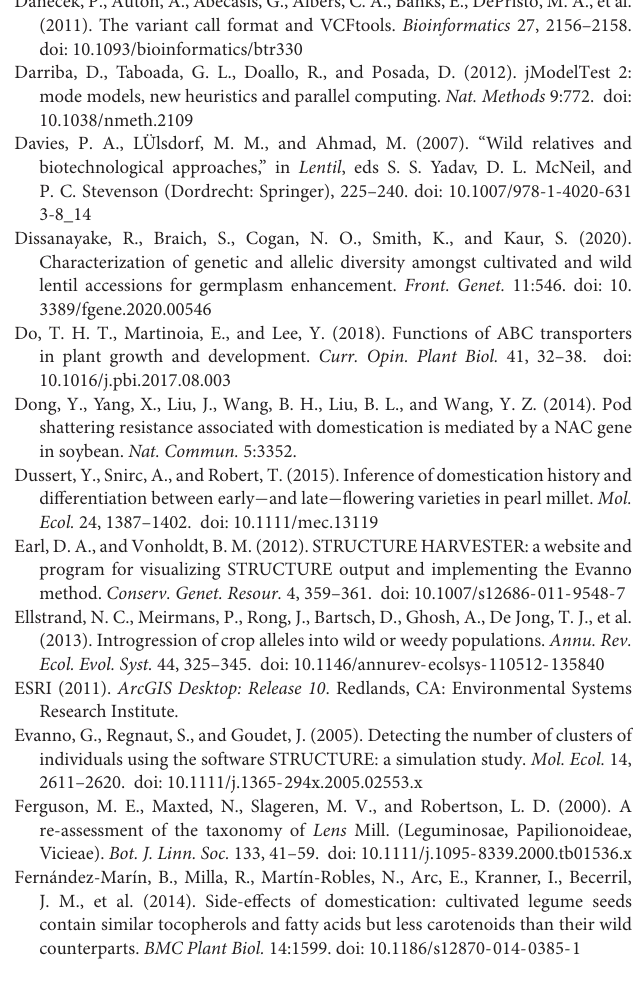
Supplementary Table 1 | List of accessions considered to be mislabeled or hybrids and why. Supplementary Table 2 | Genetic diversity measures for species and selected groups within the Lens genus based on a filtered dataset without any missing data (4,421 SNPs). Supplementary Table 3 | F ST (below diagonal) and Nei’s genetic distance (above diagonal) between L. culinaris groups defined in the STRUCTURE K = 4 model. Supplementary Table 4 | F ST (below diagonal) and Nei’s genetic distance (above diagonal) between culinaris groups defined in the STRUCTURE K = 4 model and the two orientalis sub-groups defined in the STRUCTURE K = 2 model with orientalis accessions only. Supplementary Table 5 | Markers identified in a GWAS for association between SNPs and domesticated status as well as environmental variables. Supplementary Table 6 | List of accessions used in this study, their source, geographical provenance, species indicated in the passport data, species attribution based on our population structure data, GBS statistics, improvement status and group in STRUCTURE analysis (accessions labeled “Mixed” have less than 40% of proportional membership to any